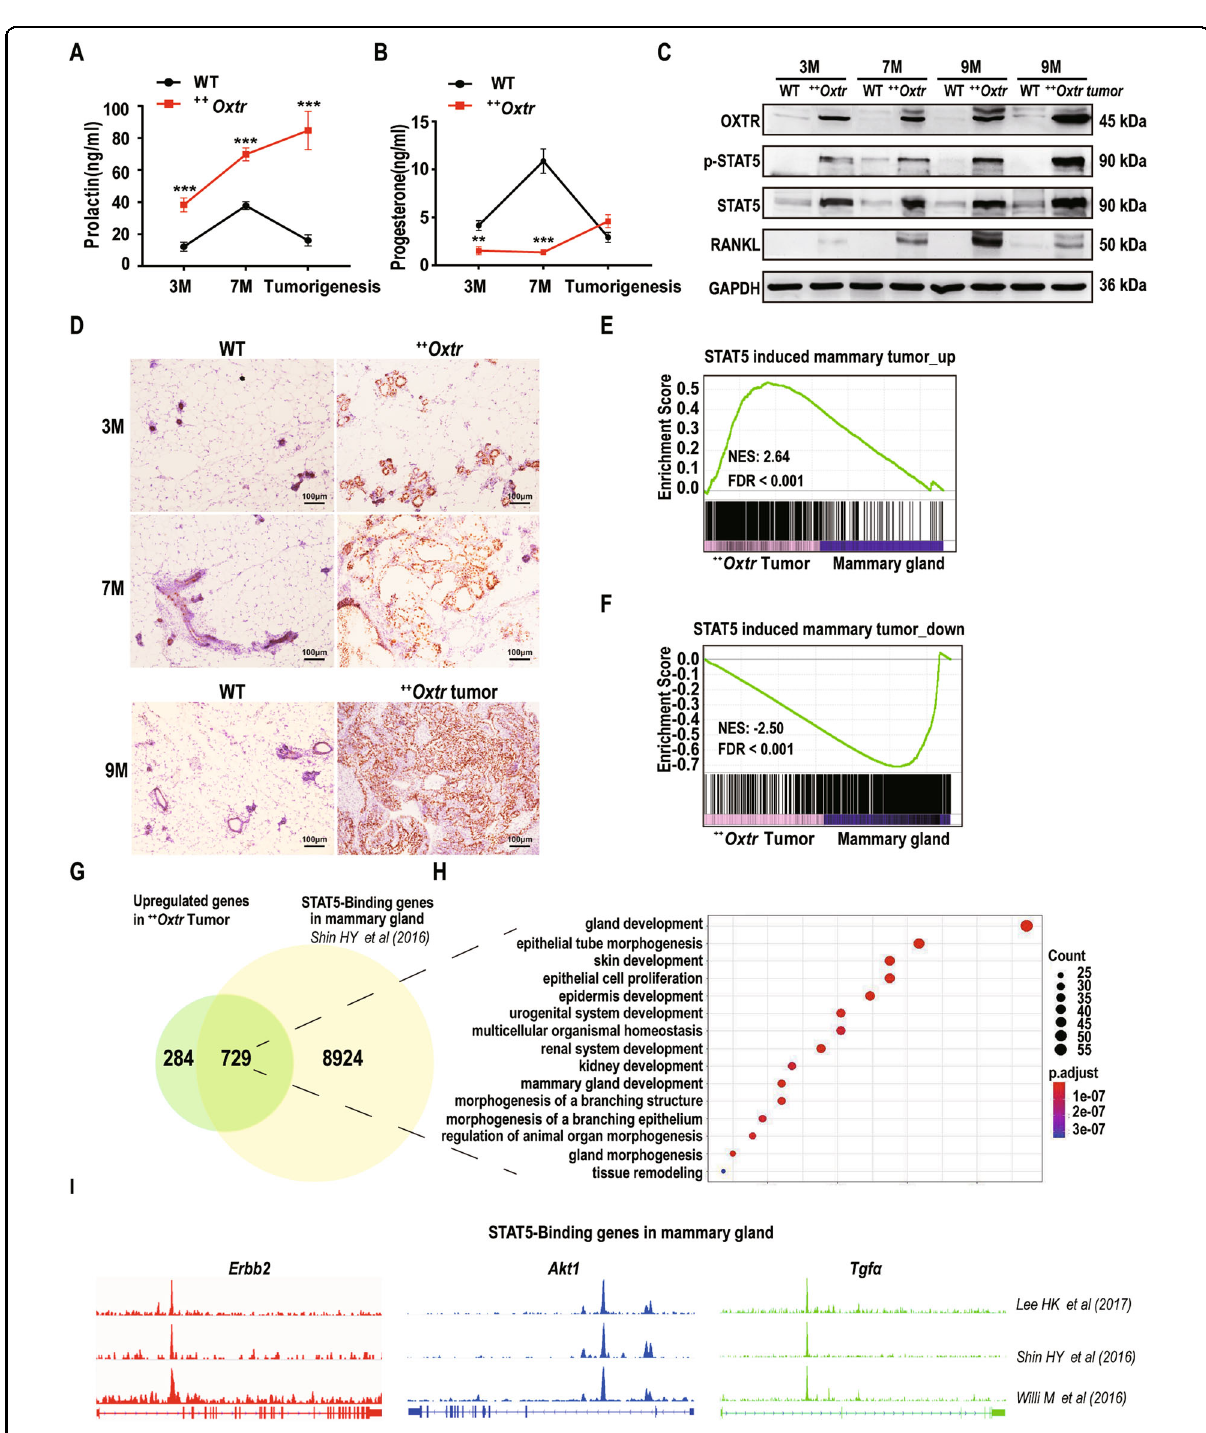
Fig. 4 OXTR overexpression activates PRL/p-STAT5/RANKL pathway at various stages (3 M, 7 M, 9 M, Tumorigenesis). A Serum prolactin levels, n = 5. B Serum progesterone levels, n = 5. C Immunoblotting analysis of OXTR, p-STAT5, STAT5, and RANKL from fourth mammary gland of + + Oxtr , WT, and ++ Oxtr tumors. GAPDH is the loading control. D Immunostaining of p-STAT5 from fourth mammary gland of ++ Oxtr , WT, and ++ Oxtr tumors. Nuclei were stained blue with hematoxylin. Scale bar: 100 μ m. E GSEA plots evaluating enrichment of upregulated genes of STAT5-induced mammary tumors 31 (Data from GSE15119 were reanalyzed) in ++ Oxtr tumors. F GSEA plots evaluating enrichment of downregulated genes of STAT5- induced tumors 31 in ++ Oxtr tumors. G Venn diagram displayed the overlap between STAT5-binding genes 32 (Data from GSE74826 were reanalyzed) and the upregulated genes in ++ Oxtr tumors. H Ontology analysis of overlapping genes between OXTR-upregulated and STAT5-binding genes. I ChIP-seq pro fi les of STAT5 on Erbb2 , Akt1 , and Tgf α in mouse mammary gland 32 – 34 (Data from GSE2492061, GSE74826, and GSE82275 were obtained). Data represented as mean ± SD. ** P < 0.01, *** P < 0.001, calculated using two-tailed unpaired t